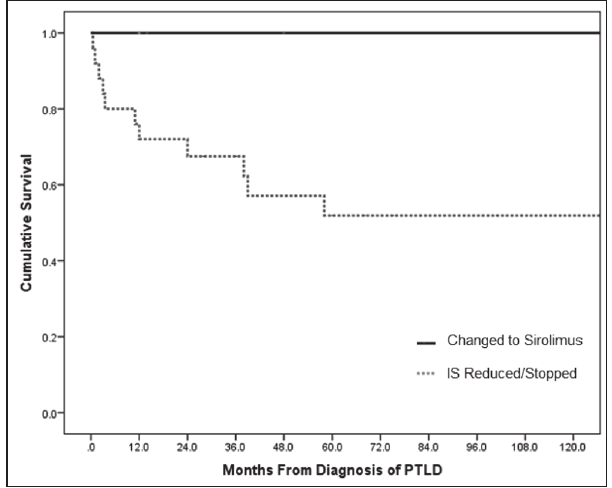
Figure 4) Kaplan-Meier curve comparing survival among patients with complete response (n=25) and partial response (n=7) with post-transplant lymphoproliferative disorder (PTLD)